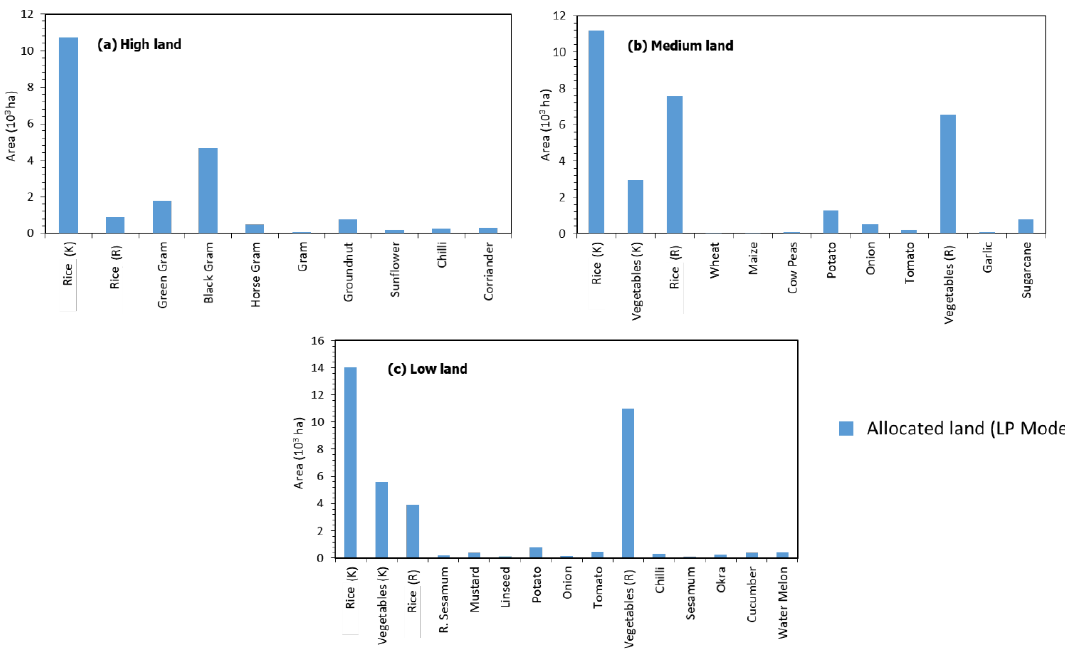
Figure 8. Comparison of cropping pattern obtained from ROM (Resource Optimization Model) by linear programming (LP) for: ( a ) high land, ( b ) medium land, and ( c ) low land. ‘K’ refers to the Kharif season and ‘R’ refers to the Rabi season.